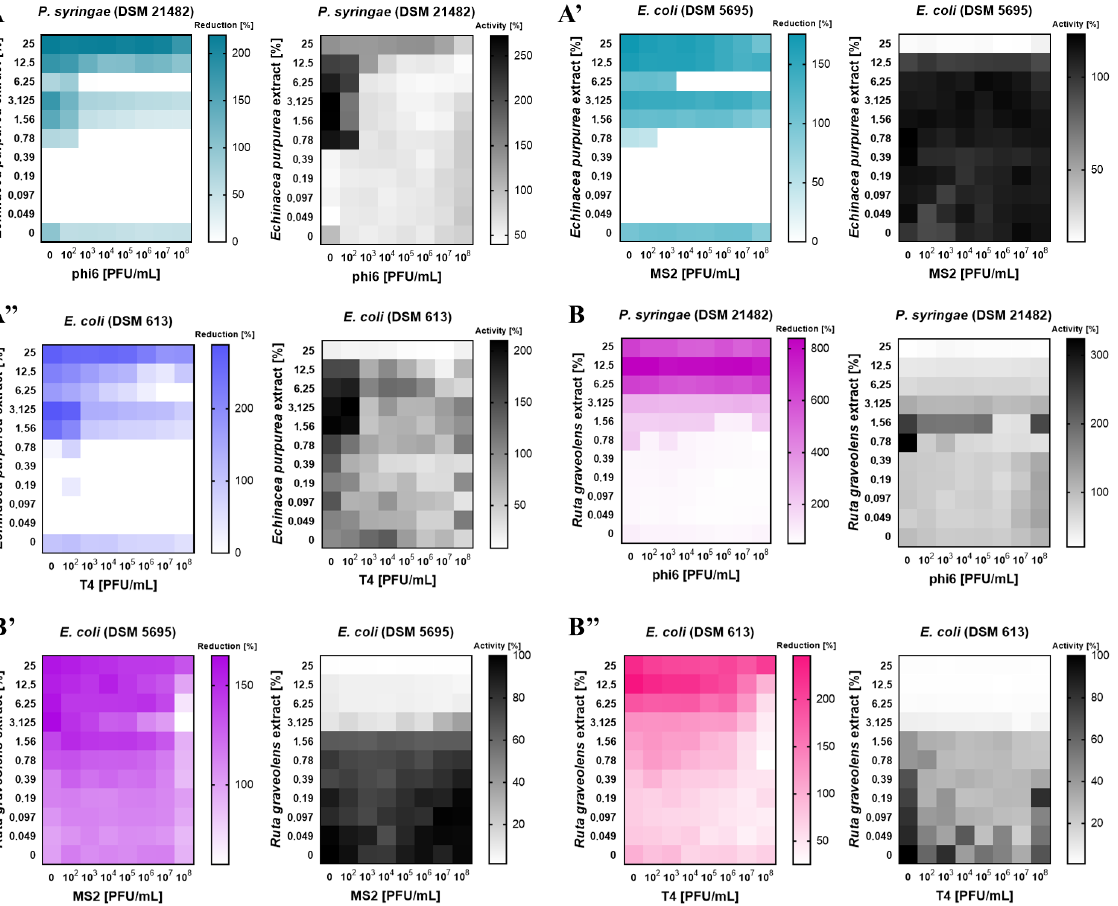
Figure 4. Effects of phage–extract combinations on host bacterial growth. Coloured heatmaps represent OD 600nm measurements, and black and white heatmaps represent corresponding fluorescence measurements. Combined treatment of phages with the Echinacea purpurea extract ( A – A” ), combined treatment of phages with the Ruta graveolens extract ( B – B” ). Synograms (t = 24 h) represent the mean reduction (% of the control) or activity (% of the control) percentage of each treatment from the three replicates.